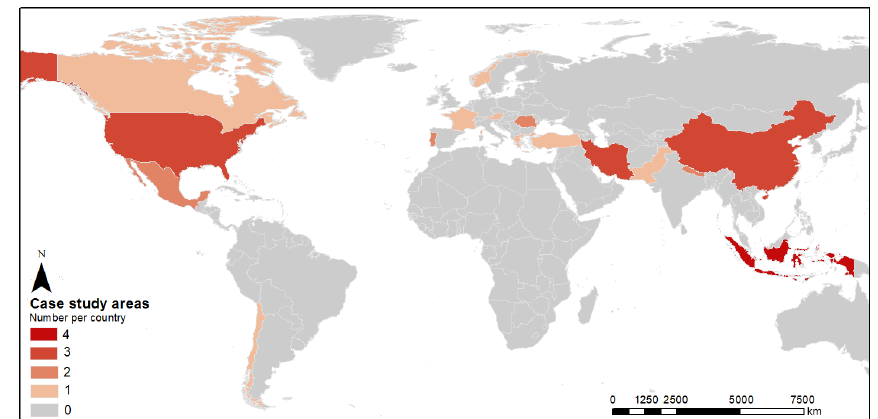
Figure 3. Number of study areas per country addressed in the references identified through the systematic literature